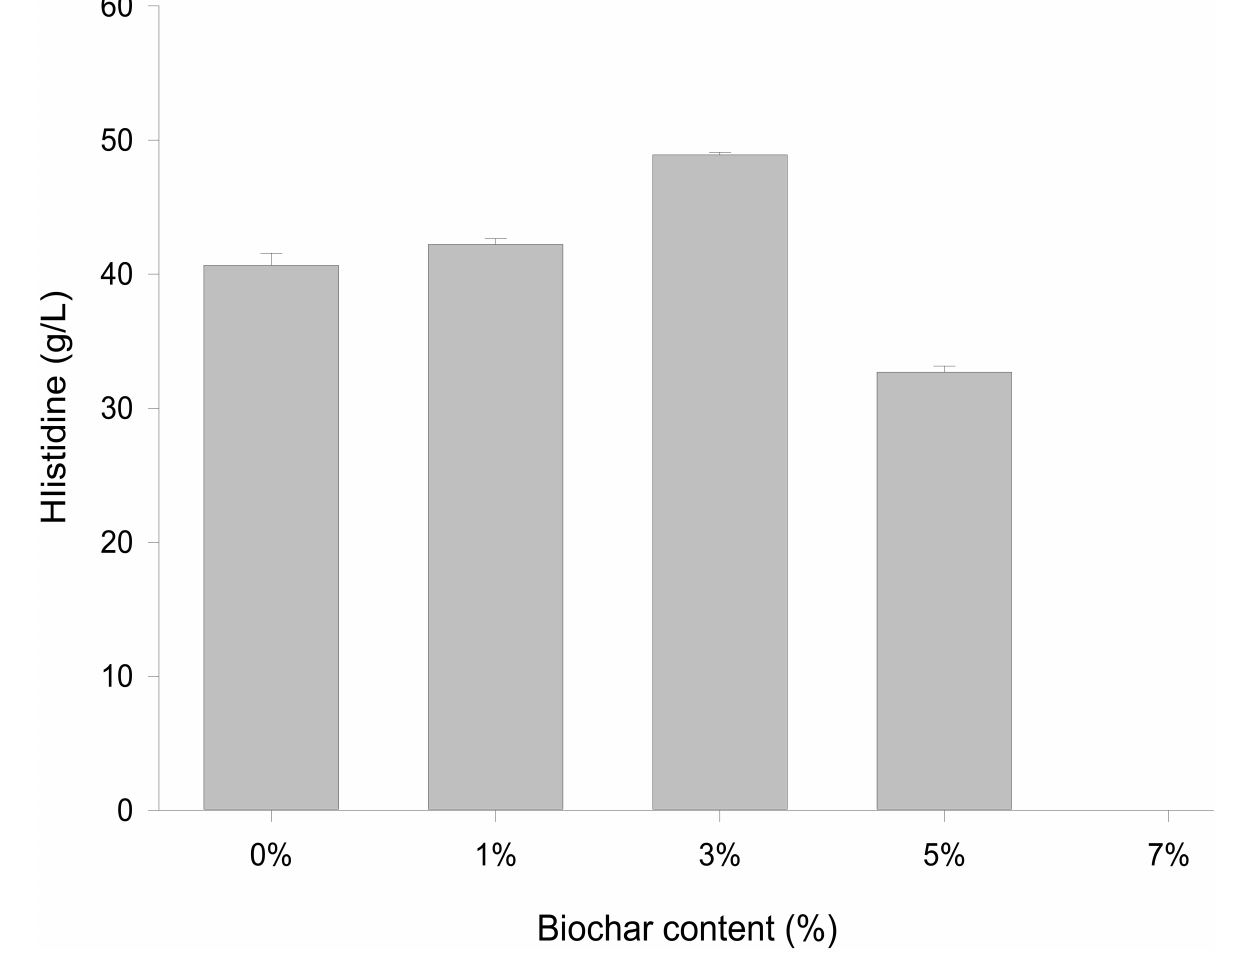
FIGURE 2 | The concentration of L-histidine production with different biochar treatments after 48 h.